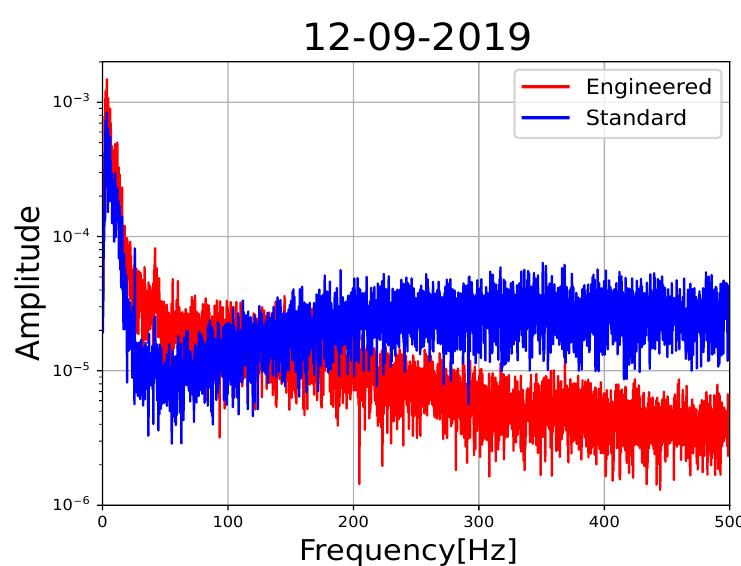
Figure 6. Smoothed spectrum of standard fiber (fiber instance one) and engineered fiber in blue and red curves, respectively. The smoothing is performed by taking only the prominent peaks of each original spectral curve. Original curves are shown in the Supplementary